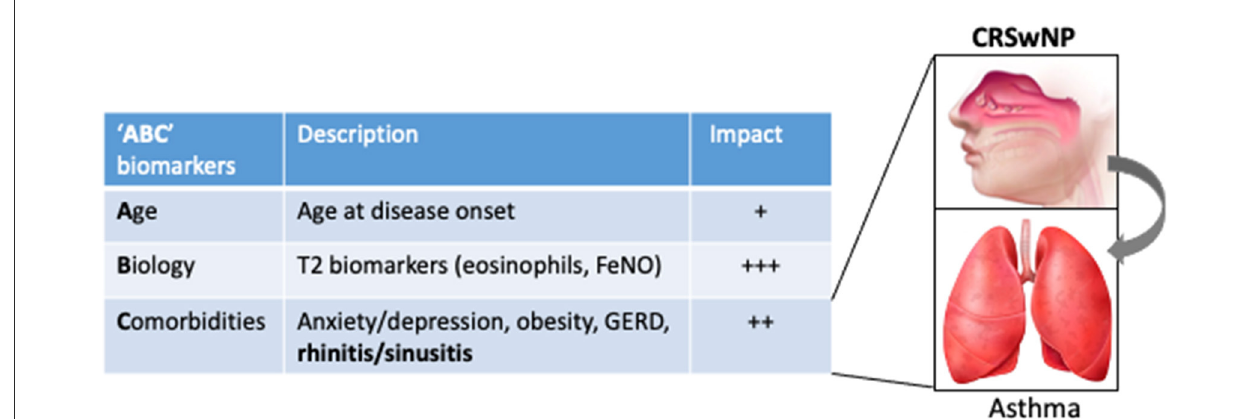
FIGURE1 The “ABC” sets of biomarkers that influence the response to biologics in severe asthma, illustrated by their respective estimated impact on the response to anti–IL-5 therapies. For instance, the impact calculated (odds ratio, OR) for adult onset and CRSwNP on the probability to be defined as a responder to mepolizumab in a “real-life” series (88) were 1.20 and 1.36 (vs. the absence of CRSwNP), while it was not significant for eosinophils. Inset , illustrating the impact of UAD (in particular CRSwNP) on asthma outcomes upon